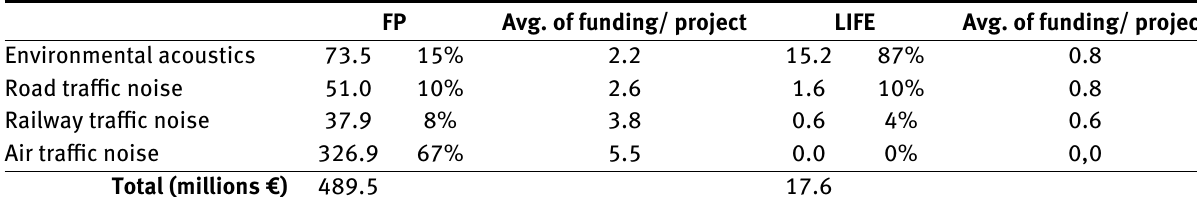
Table 2: EU funding distribution and average of funding per project, according to research topics and programmes (in millions €).